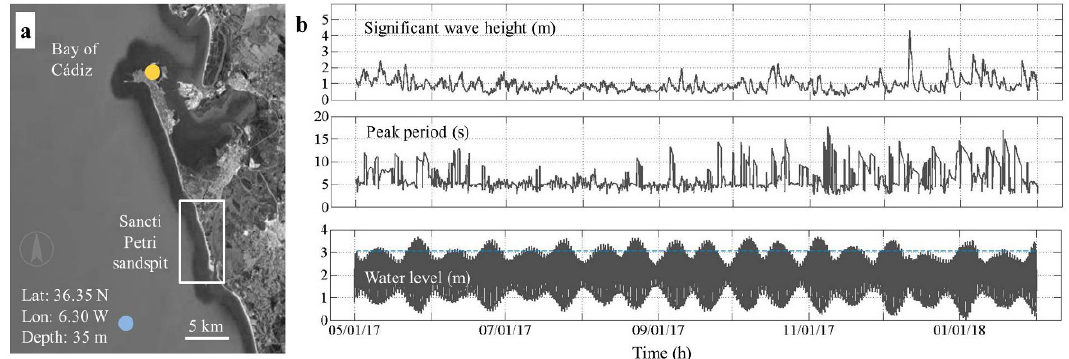
Figure 6. ( a ) Location of the tidal station (yellow dot) and the SIMAR point 6,012,036 (blue dot); ( b ) oceanographic conditions from May 2017 to January 2018 (the dashed blue line in the water level time series represents the berm elevation measured in October 2017).